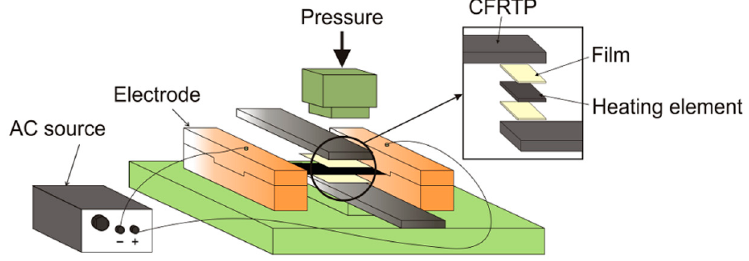
Figure 3. Schematic drawing of resistance welding.